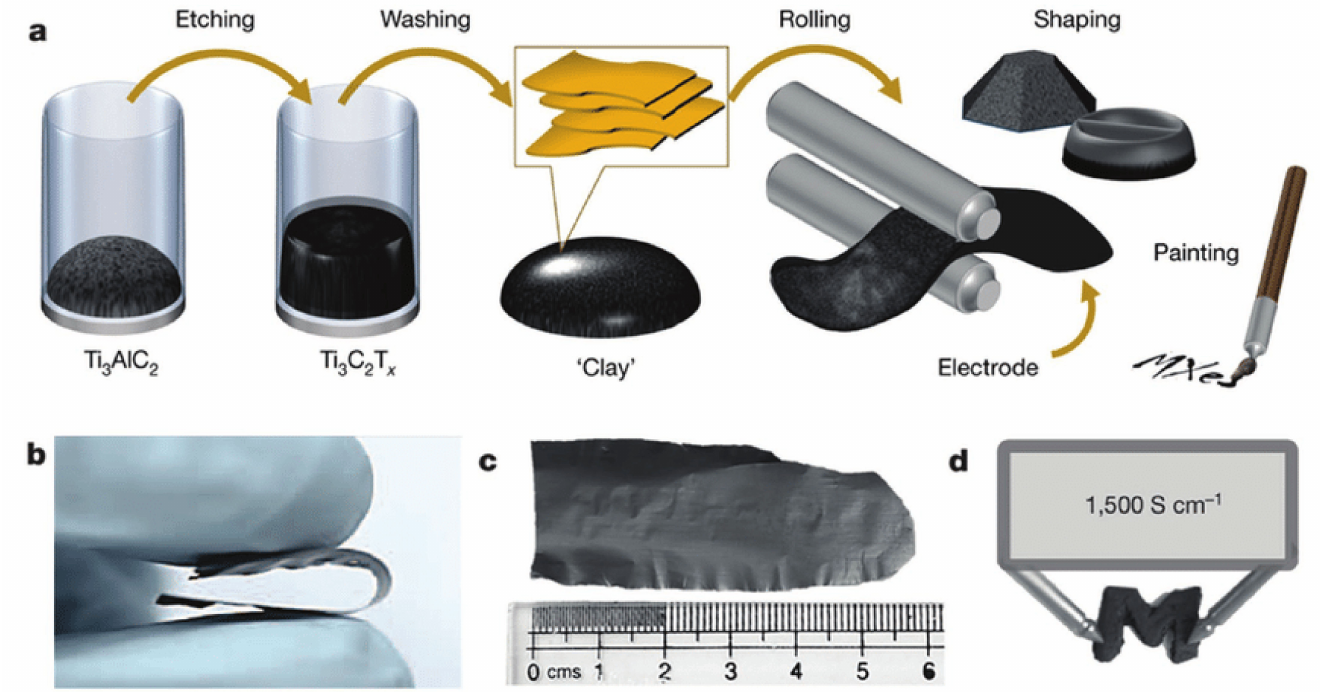
Figure 4. Free-standing titanium carbide clay film. ( a ) Schematic diagram of MXene formation with MAX phase powder being etched and then subsequently washed to remove impurities. The resultant product behaves like clay, which can be rolled and is flexible enough to make free-standing films. ( b ) If the dried samples are hydrated; swelling happens immediately. Again drying makes them shrink ( c ) Rolled film image. ( d ) The clay is bent to give it an ‘M’ shape. Then it is dried forming a conductive solid. Reproduced with permission from [41] (Ghidiu et al., 2014). Copyright 2014, Nature Publishing